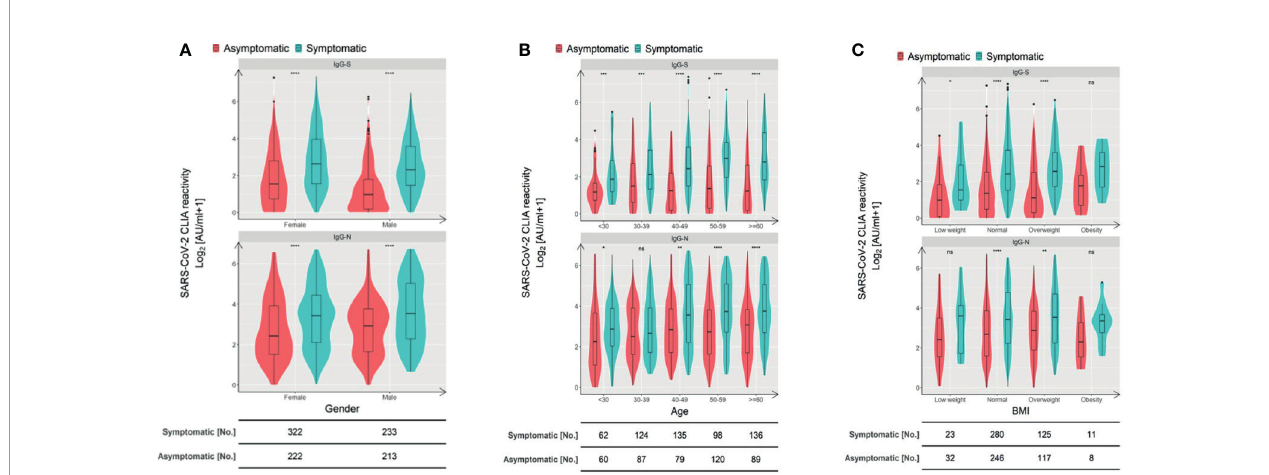
FIGURE 3 | Symptom occurrence is the dominant factor de fi ning the strength of SARS-CoV-2-speci fi c IgG responses. Comparison of RBD S- and N-speci fi c CLIA-reactive IgG titers strati fi ed according to sex (A) , age (B) , and BMI (C) . Violin plots show the distribution of each antibody feature derived from asymptomatic individuals (red) and symptomatic patients (blue). Boxes depict medians (middle line), 75% quartiles (upper bound), and 25% quartiles (lower bound) with whiskers showing a 1.5-fold interquartile ranges above and below boxes. The table below the fi gure indicates the number of samples obtained from asymptomatic individuals and symptomatic COVID-19 patients. Statistical analysis was performed by a two-tailed Mann-Whitney U test. Asterisks depict the levels of signi fi cance as follows: ns, not signi fi cant (p ≥ 0.05); *p < 0.05; **p < 0.01; ***p < 0.001; ****p <